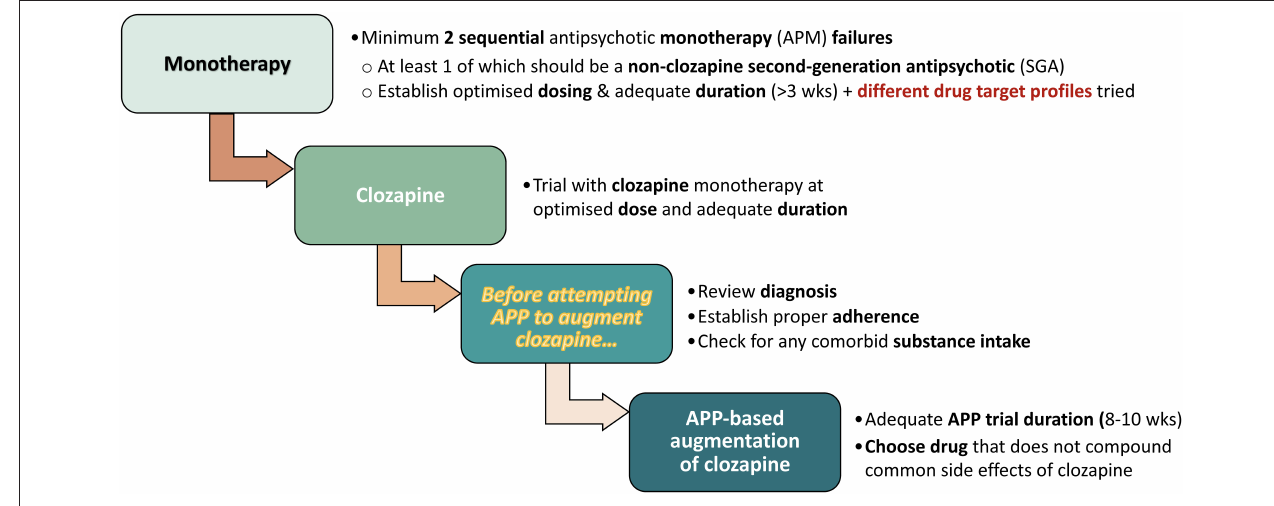
FIGURE 2 | Stepwise transition to APP, based on NICE, UK, Clinical Guidelines (5).